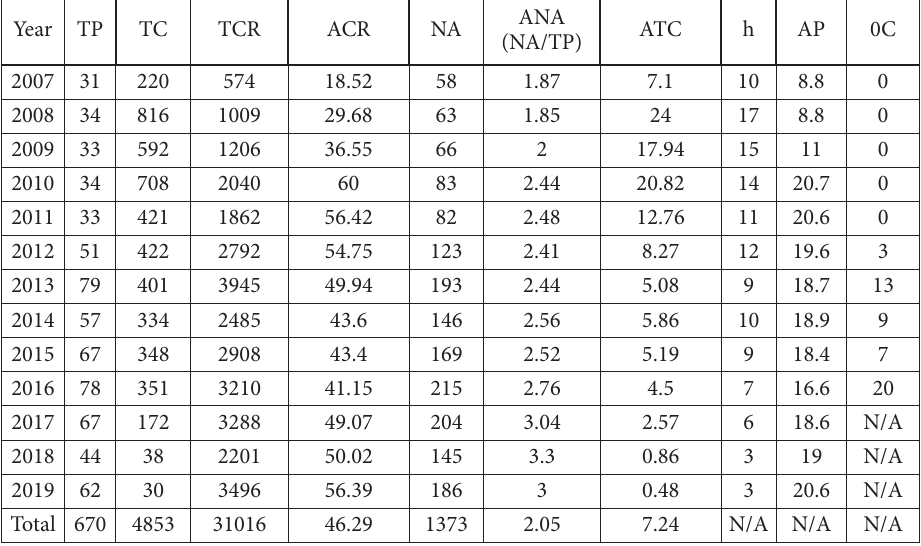
Table 1. Publishing profile of the